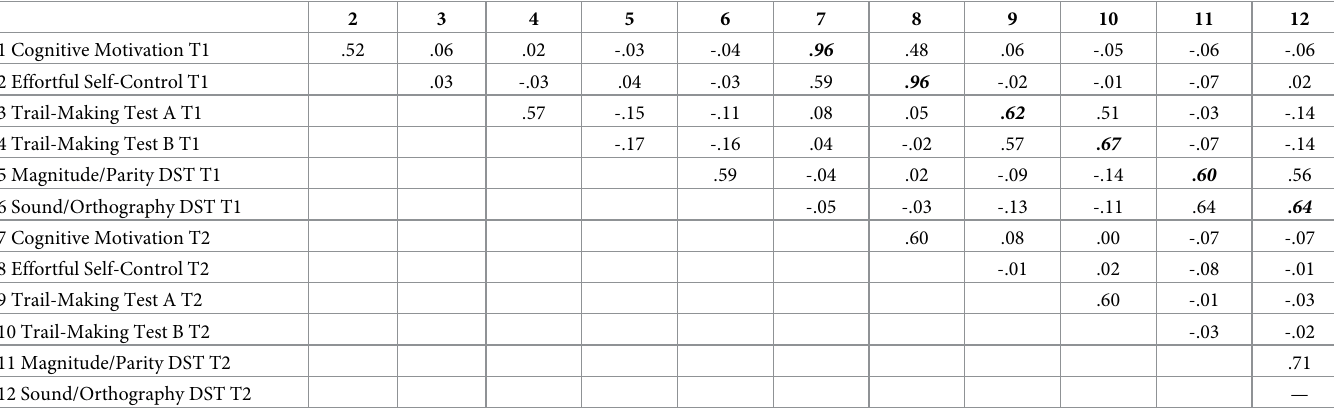
Table 3. Pearson correlations of the normalized variables used for latent state-trait modeling: Original demand avoidance measure.